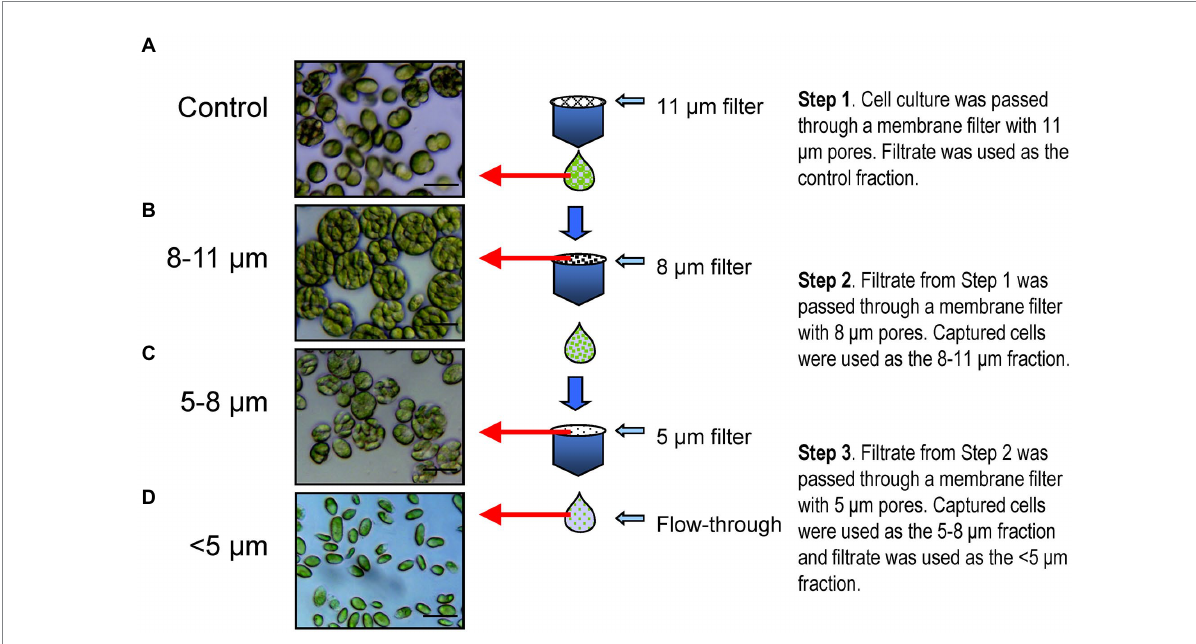
FIGURE 3 Membrane filtration procedure carried out for the separation of different sized cell units. Step 1. Dilute cell culture was passed through 11 μ m hydrophilic nylon net filters by gravity flow, using a glass filter holder. Cells captured on the filter were discarded and the flow-through filtrate was utilized as the control fraction (A) . This control cell suspension was passed through hydrophilic polycarbonate membrane filters with 8 μ m pores with the aid of gentle vacuum aspiration. Cells retained on the filters were washed with culture medium, re-suspended and centrifuged to concentrate the cells, which were used as the 8–11 μ m fraction (B) . The flow-through filtrate was passed through hydrophilic polycarbonate membrane filters with 5 μ m pores using gentle vacuum aspiration. Cells retained on the filters were washed, resuspended in culture medium and centrifuged as for the previous step, and used as the 5–8 μ m fraction (C) . The flow-through filtrate was centrifuged and used as the single cell enriched, <5 μ m fraction (D) . Fractions were monitored using light microscopy ( A–D , left). Scale bars, 20 μ